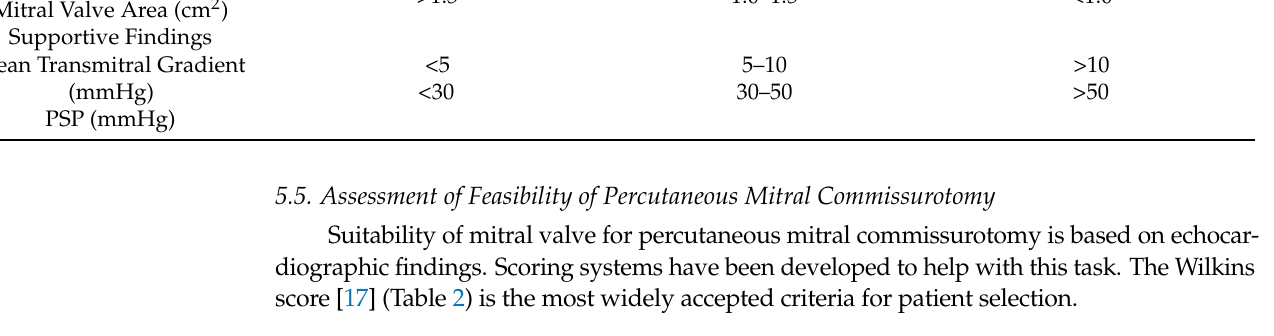
Table 1. Classification of mitral stenosis severity at heart rates between 60 and 80 bpm and in sinus rhythm. Adapted from from Baumgartnet et al. [10].